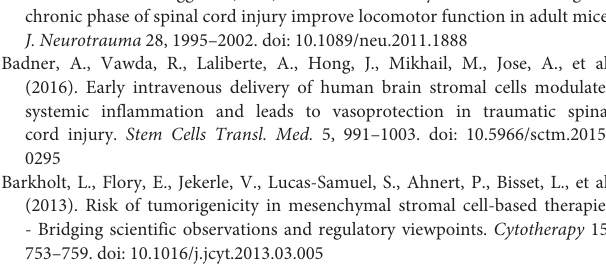
SUPPLEMENTARY FIGURE 1 | Bladder functionality after tSCI. Time course of the bladder functionality score after tSCI for vehicle-treated, i.pa. EVs-treated as well as i.v. EVs-treated rats. Urinary bladder voiding function was assessed according to filling volumes detected by palpation (1 = very large; 7 = empty